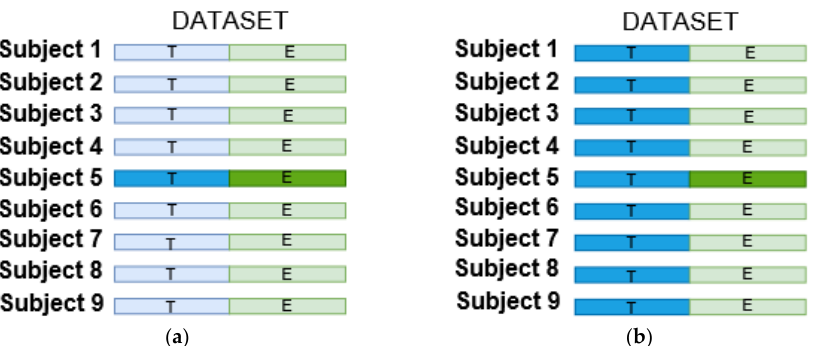
Figure 3. The training ( T in blue) and testing ( E in green) set selections for both strategies: ( a ) subject- specific; ( b ) non-subject-specific.